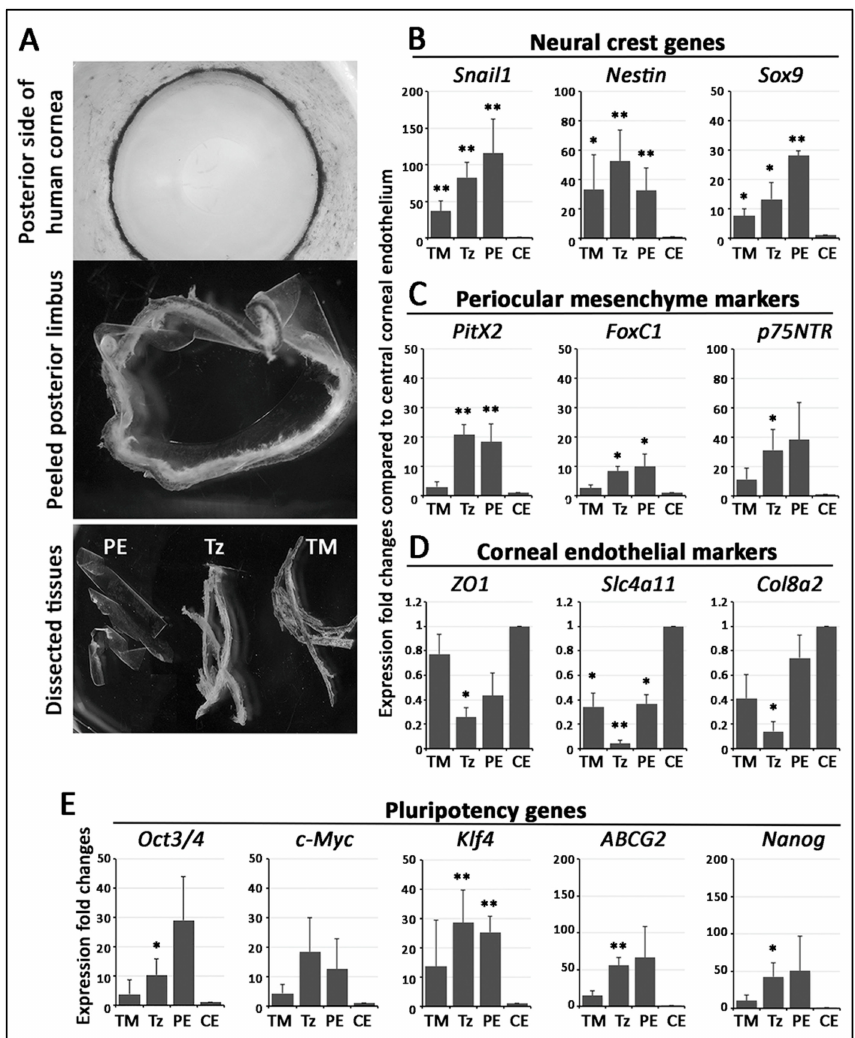
Figure 2. RNA expression in isolated human posterior limbus tissue. ( A ) Microdissection of posterior limbus into trabecular meshwork (TM), transition zone (TZ) and peripheral endothelium (PE) tissues for total RNA extraction. Target gene expression in various tissues compared to central corneal endothelium (CE). Data are presented as mean expression fold changes and SD. ( B ) Neural crest markers ( Snail1 , Nestin , Sox9 ). ( C ) POM markers ( Pitx2 , FoxC1 , p75 NTR ). ( D ) Corneal endothelial di ff erentiation marker ( ZO1 , Slc4a11 , Col8a2 ). ( E ) Pluripotency markers ( Oct3 / 4 , c-Myc , Klf4 , ABCG2